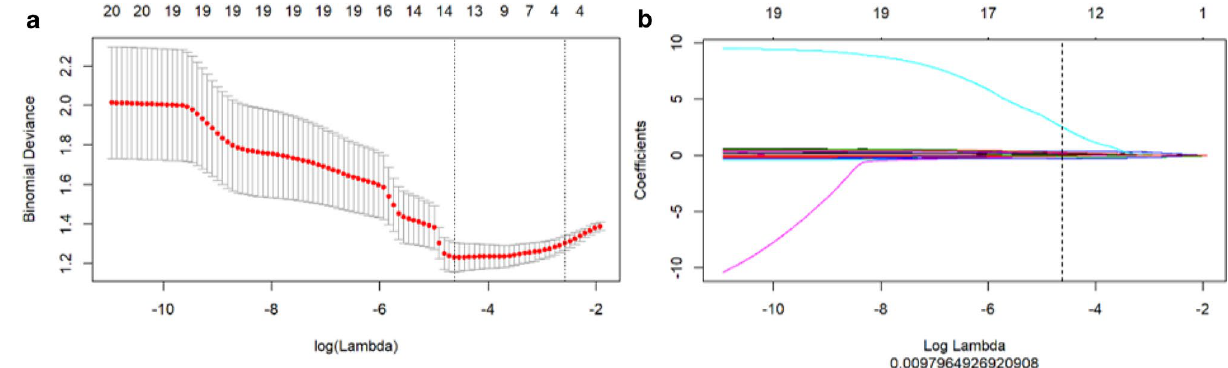
Figures 2. ( a ) Screening of the radiomics features was performed through LASSO regression. The cross- validation for LASSO regression, where the parameter λ was adjusted to find the best function set, is shown. The vertical dotted line on the left panel represents the log(λ) corresponding to the optimal λ. The selection criterion was the minimum deviation value, i.e. -4.3. ( b ) Screening of the radiomics features was performed through LASSO regression. The coefficients of texture parameters changed with λ. The vertical line corresponds to the 10 features selected with non-zero LASSO cross-validation coefficients.